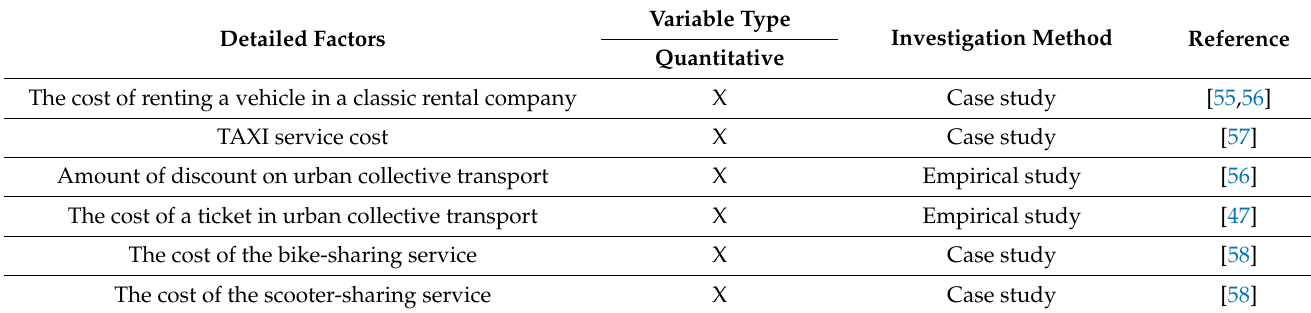
Table 2. Costs of using other means of transport.